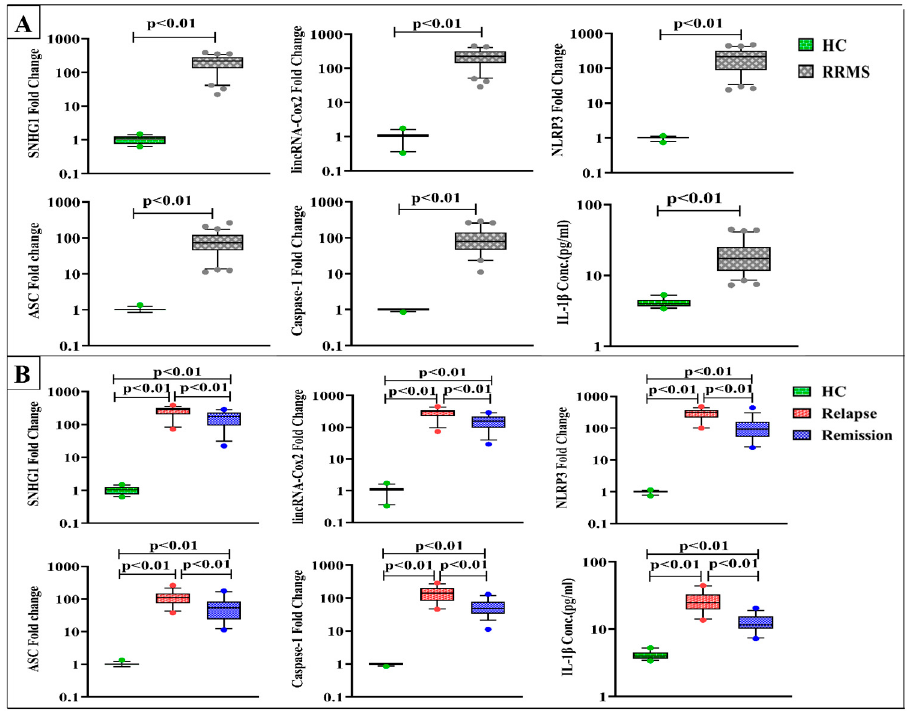
Figure 2. Expression levels of SNHG1, linRNA-Cox2, NLRP3, ASC, and caspase-1 and serum IL-1 β levels in ( A ) healthy controls (HC) (n = 30) and RRMS patients (n = 70), ( B ) HC (n = 30), RRMS patients during relapse (n = 35), and RRMS patients in remission (n = 35). Box plots show the median as a band inside each box, while boxes and whiskers delineate 25–75th and 10–90th percentiles, respectively. Dots outside the whiskers indicate outliers. Significant p -values are indicated on the graph at p < 0.01.